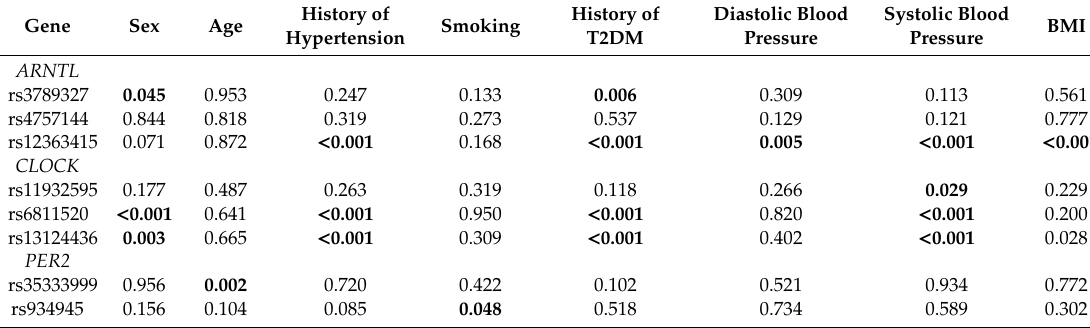
Table 6. The association between cardiovascular risk factors and circadian rhythm gene polymorphisms in patients with